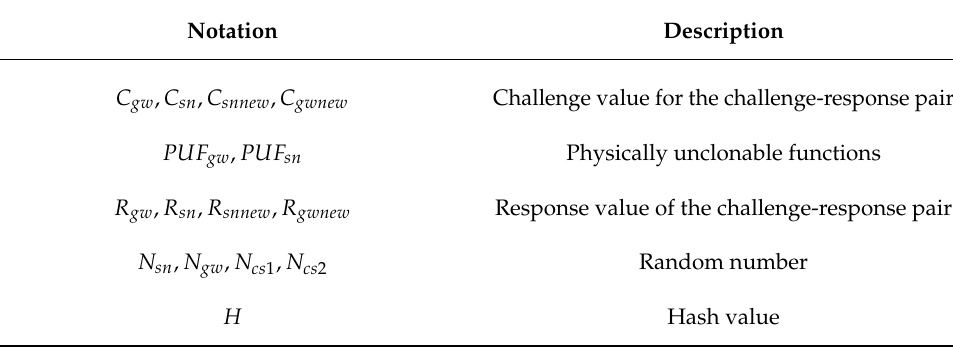
Table 1. Symbol meaning